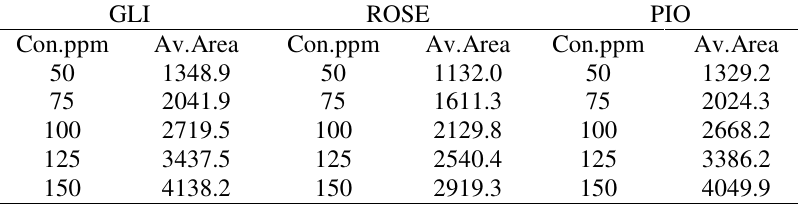
Table 4. Linearity or calibration